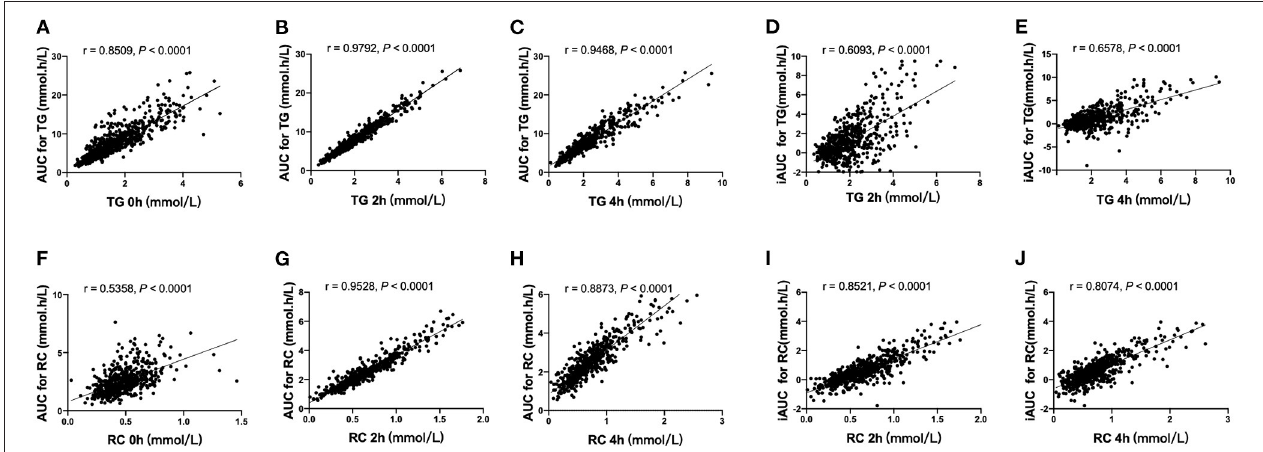
FIGURE 2 | Correlation analysis of AUCs for TG and RC with blood lipid concentration in the fasting and non-fasting state. (A–C) The correlation between AUC for TG and serum concentrations of TG in the fasting state (A) , at 2h (B) and 4h (C) . (D,E) The correlation between iAUC for TG and serum concentrations of TG at 2h (D) and 4h (E) . (F–H) The correlation between AUC for RC and serum concentrations of RC in the fasting state (F) and at 2h (G) and 4h (H) . (I,J) The correlation between iAUC for RC and serum concentrations of RC at 2h (I) and 4h (J)